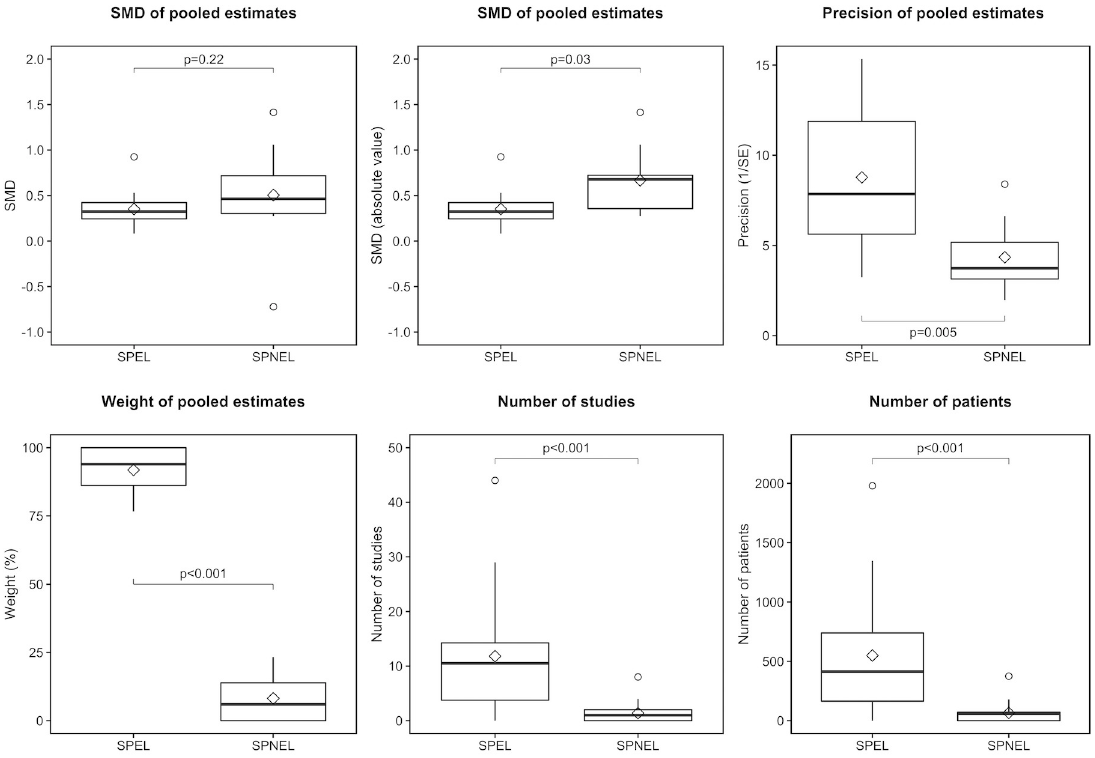
Fig 3. Comparison of treatment effect estimates between SPEL and SPNEL. SE, standard error; SMD, standardised mean difference; SPEL, studies published in English language; SPNEL, studies published in non-English language.